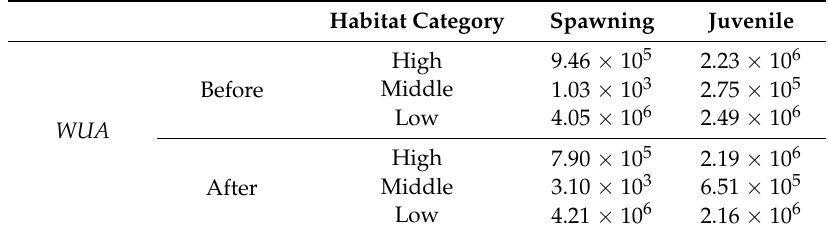
Table 2. Description of the spawning and juvenile rainbow trout weighted usable area with the